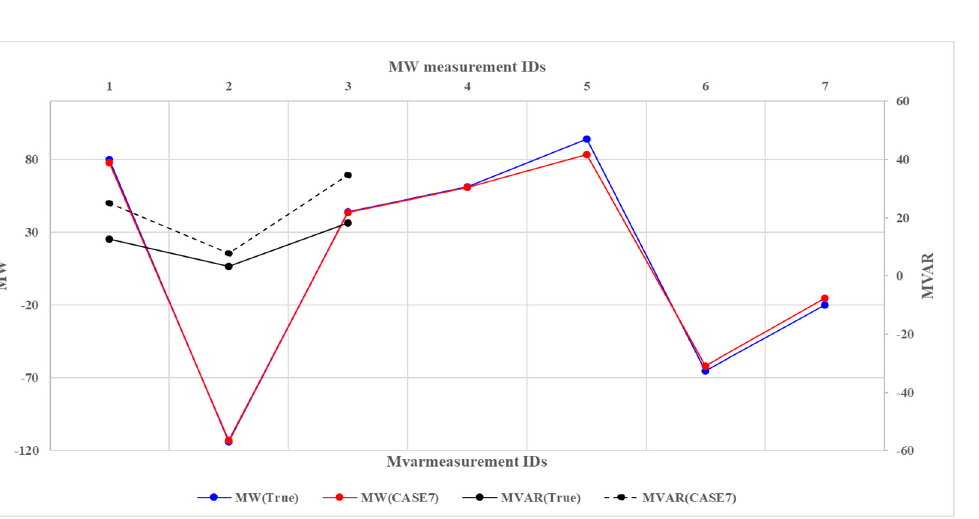
Figure 9. Comparison of MW and MVAR between true and Case